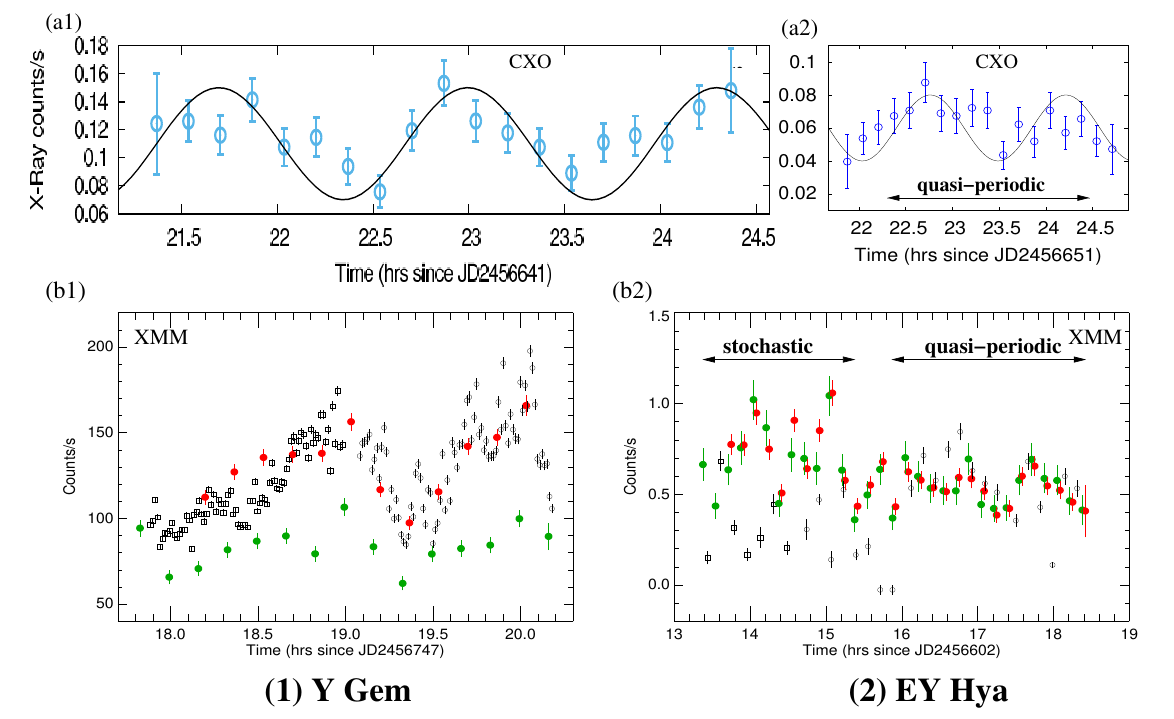
Figure 4. Short-term X-ray and UV variability in the fuvAGB stars YGem and EYHya. Panels ( a1 , a2 ) show the X-ray light curves for YGem and EYHya obtained with CXO (ACIS-S), respectively. Panels ( b1 , b2 ) show the X-ray and UV light curves for YGem and EYHya obtained with XMM (EPIC = pn + MOS1 + MOS2: red, MOS = MOS1 + MOS2: green, UVM2: black squares, UVW2: black circles), respectively. The EPIC, MOS and UVW2 data have been rescaled. Nonlinear least-squares sinusoidal fits with periods, p = 1.35h and 1.45h are shown for the X-ray light curves of YGem and EYHya in panels ( b1 , b2 ); the respective uncertainties in the periods are ± 0.026h and ± 0.055h (adapted from Sahai et al. (2015) [17]